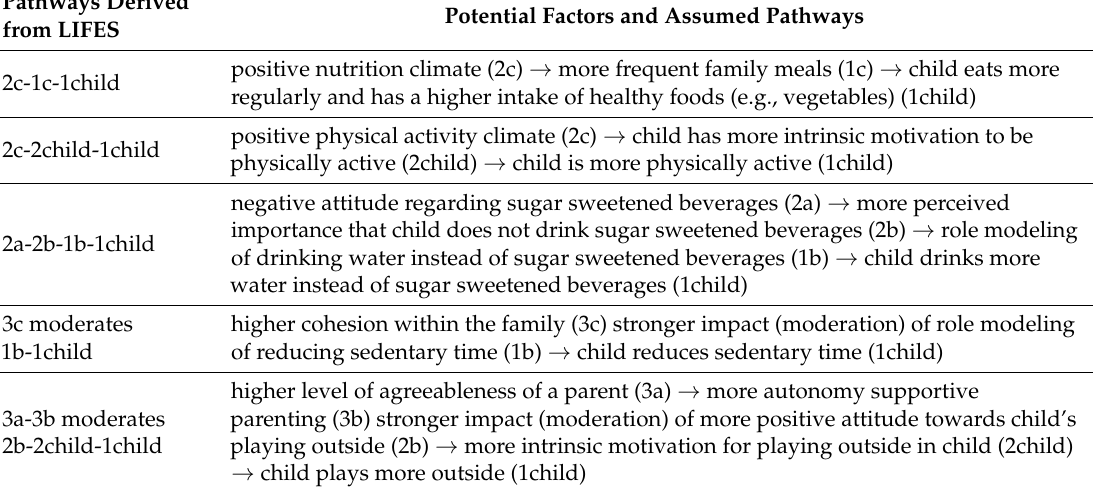
Table 1. Possible factors and assumed pathways within the LIFES